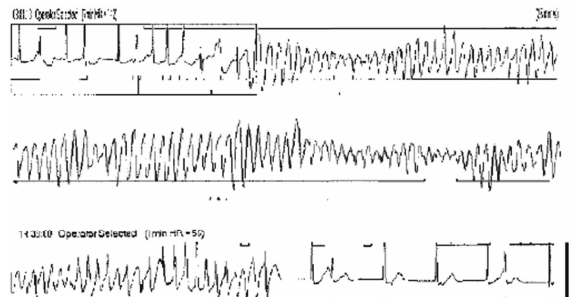
Figure 2: 12-lead ECG recorded after termination of episodes of TdP, showing prolongation of the QTc